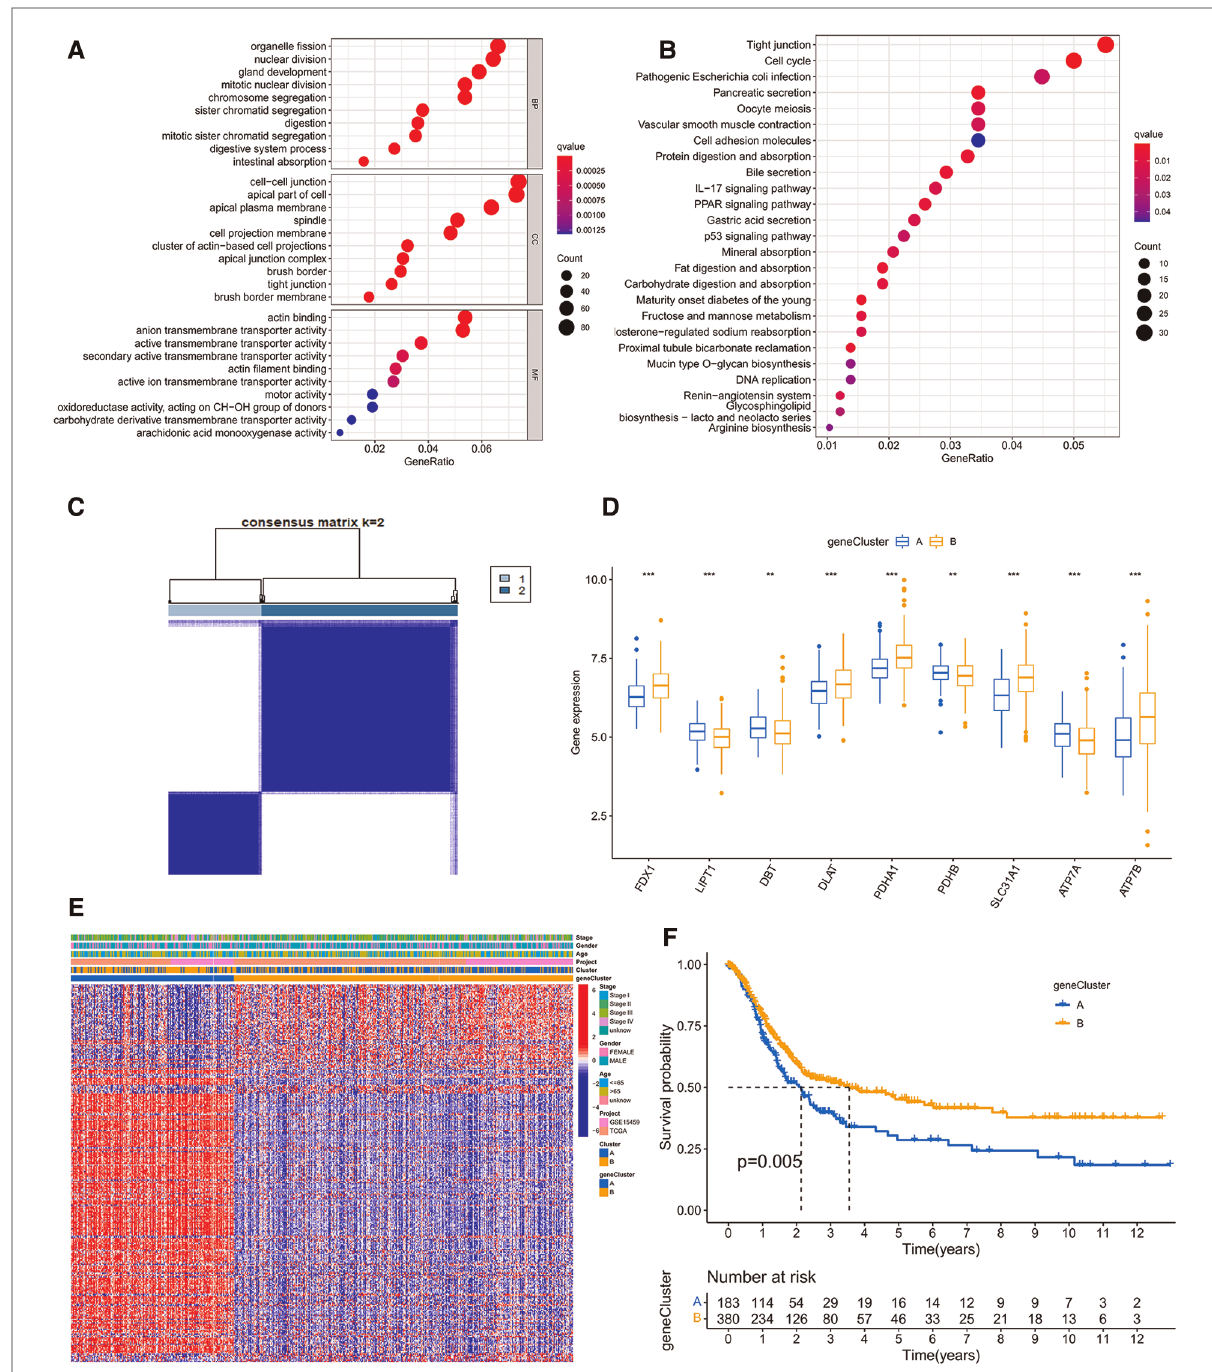
FIGURE 5 ( A ) The GO analysis based on the differentially expressed genes (DEGs). ( B ) The KEGG analysis of DEGs. ( C ) Consensus clustering matrix de fi ning two clusters ( k =2) accroding to DEGs. ( D ) The expression of CRGs between A and B geneclusters. ( E ) The heatmap showing the correlation of the subtypes and geneclusters with clinicopathological data and CRGs. ( F ) The survival curve between A and B geneclusters. GO, Gene Ontology; KEGG, Kyoto Encyclopedia of Genes and